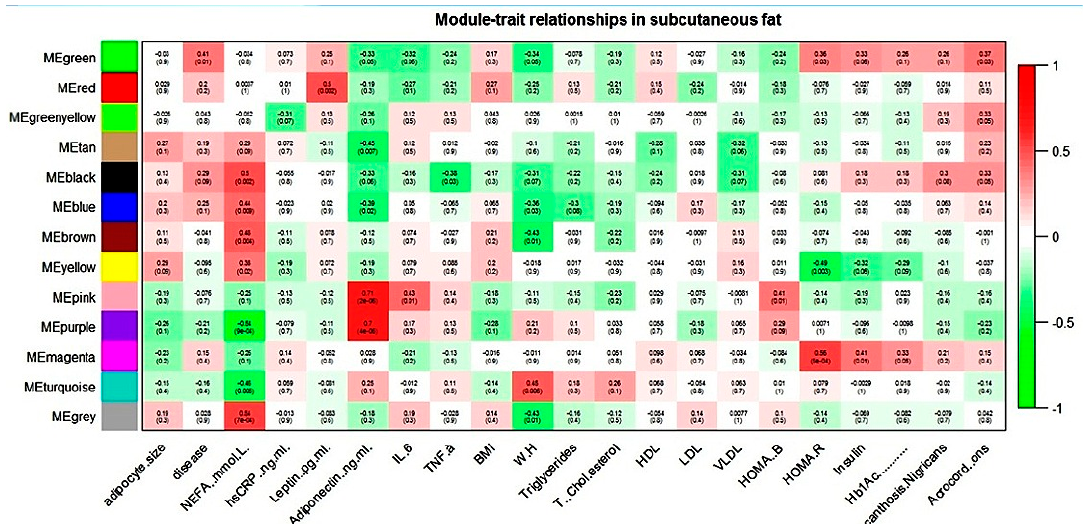
Figure 2. Module–trait relationship in subcutaneous gene expression dataset.